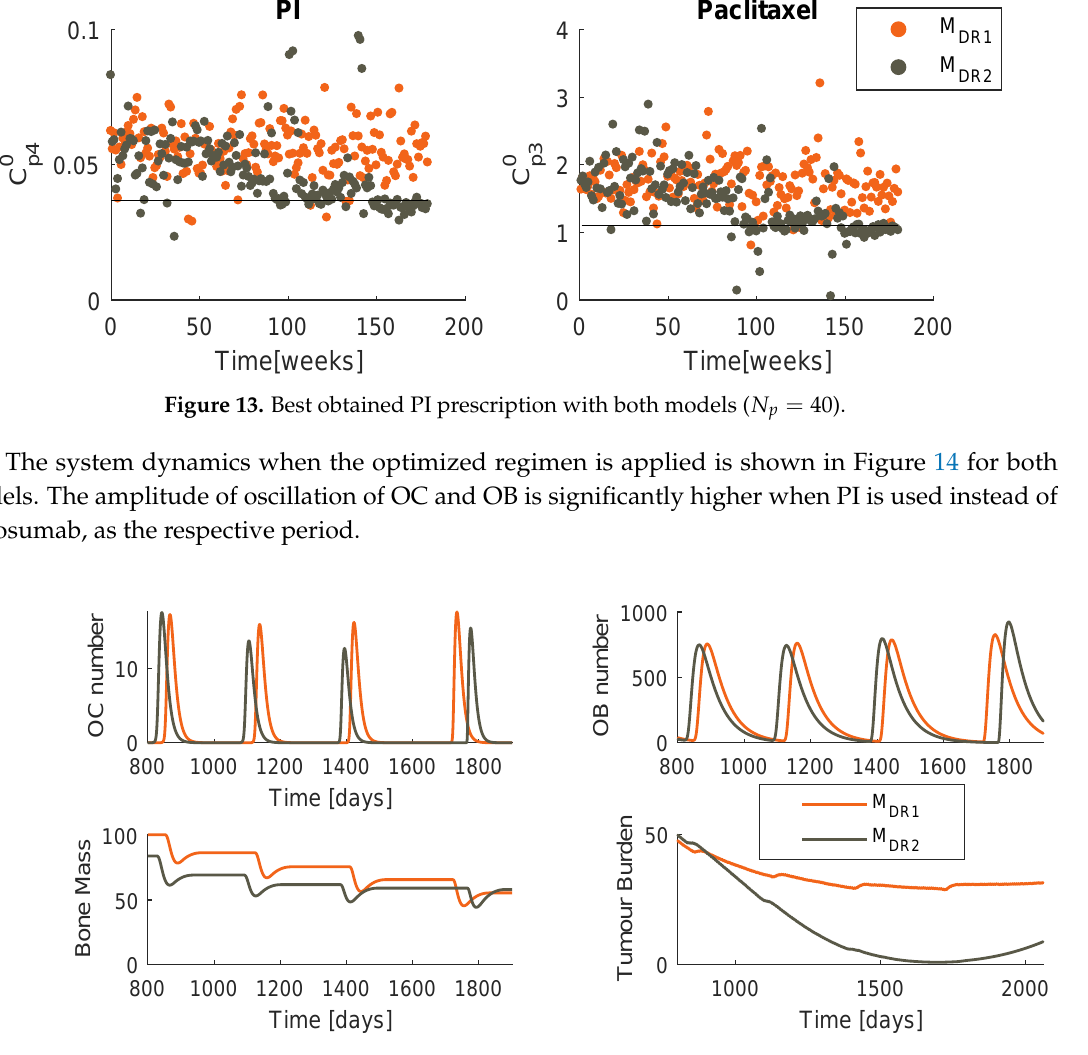
Figure 14. Dynamics of the systems M DR 1 and M DR 2 when gien an optimized prescription of paclitaxel and